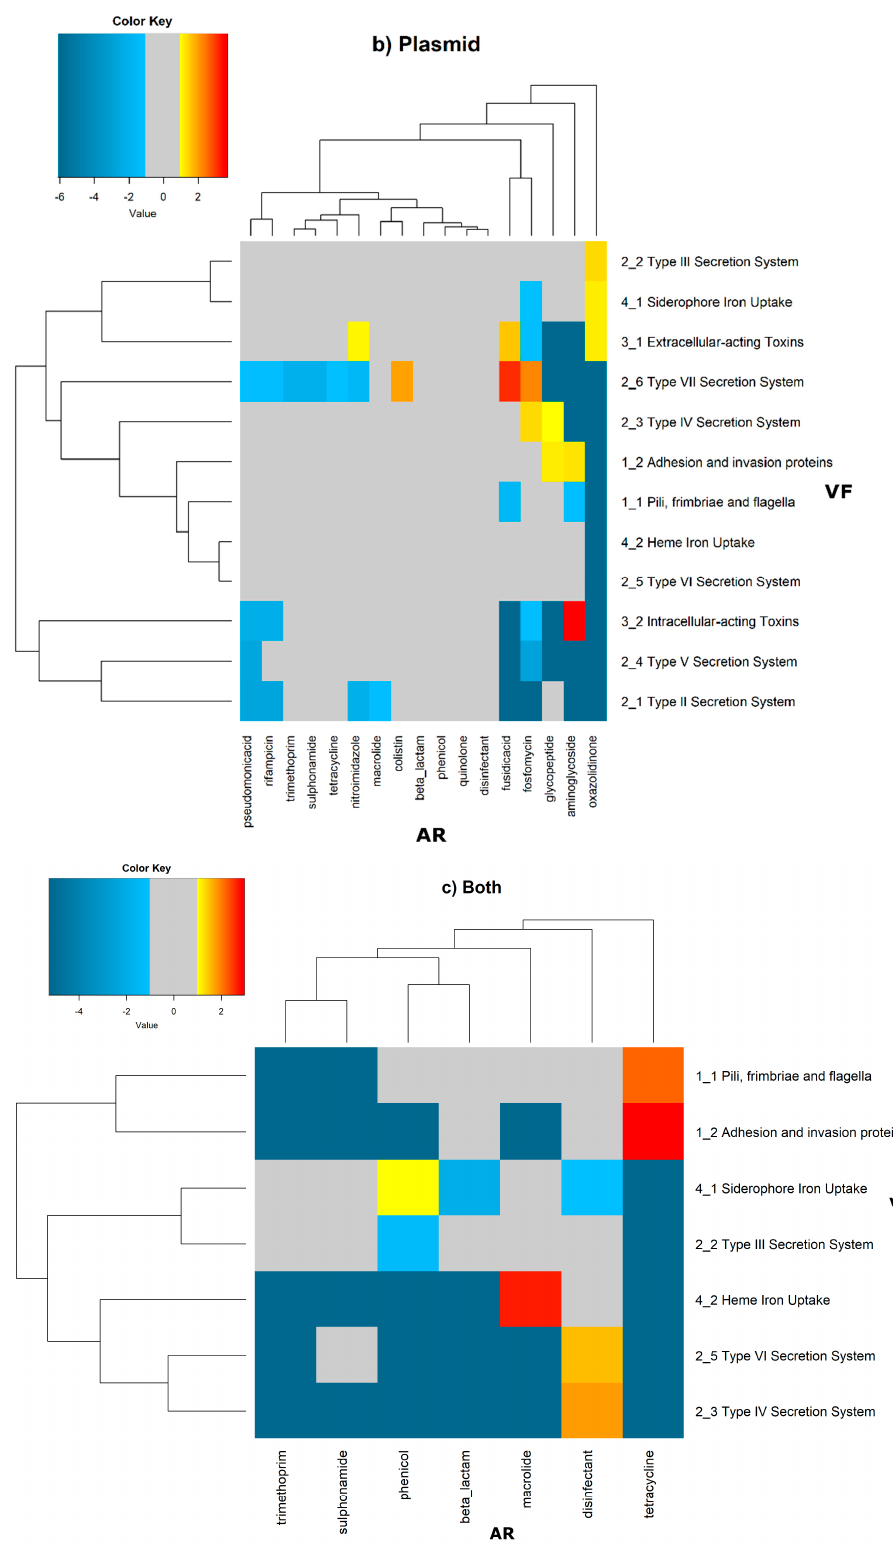
Figure 6. Heatmaps of the number of antibiotic resistance orthologues of the ResFinder database ( x axis) and virulence factor orthologues of the VFDB database ( y axis) in each genomic position. The values correspond to the Log 2 of the quotient of observed/expected values. The yellow to red shades represent a higher-than-expected number of co-occurrences; the blue shades represent a lower-than-expected number of co-occurrences; and the grey represents values close to the expected values. ( a ) The higher number of ResFinder’s orthologous proteins that co-occurred with VFDB’s orthologous in the chromosome is between type VII secretion systems and fusidic acid. ( b ) In plasmids, the high- est number of co-occurrences is between type VII secretion systems and fusidic acid and between intracellular acting proteins and aminoglycosides. ( c ) The number of co-occurrences in both the chromosome and plasmid is low. Consequently, we detected no co-occurrences involving six out of thirteen orthologues of virulence genes. There is a high number of co-occurrences of disinfectant orthologues with type IV and type VI secretion systems. The highest number of co-occurrences is between adhesion and invasion proteins and tetracyclines and between heme-mediated iron uptake and macrolides.